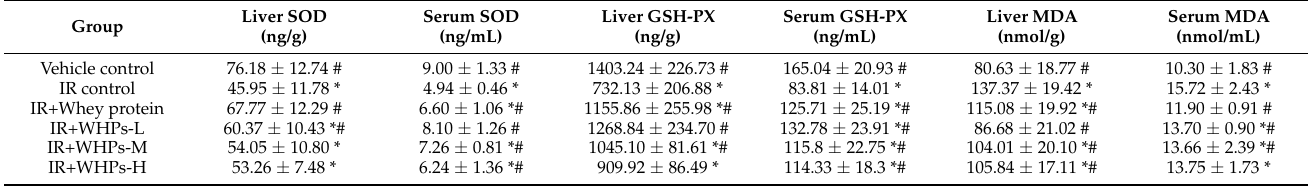
Table 7. Effect of WHPs on antioxidant defense systems at day three after radiation ( n = 12, x ± s). Group